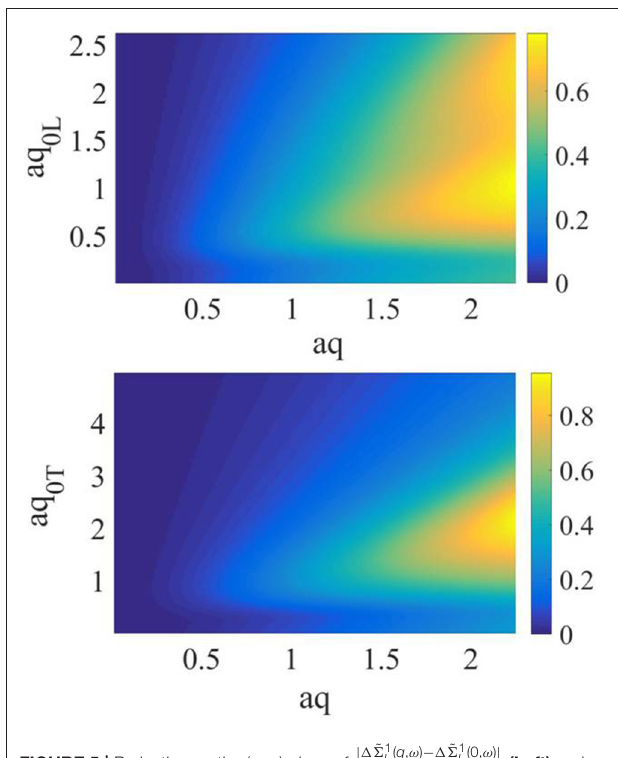
˜ 6 1 ˜ 6 1 L ( q , ω ) − 1 L (0, ω ) | FIGURE 5 | Projection on the ( ω , q ) plane of | 1 (Left) and | 1 ˜ 6 1 L (0, ω ) | | 1 ˜ 6 1 T ( q , ω ) − 1 ˜ 6 1 T (0, ω ) | (Right) for an exponential decay of the covariance | 1 ˜ 6 1 T (0, ω ) | function. The values of the theory’s input parameters are listed in the